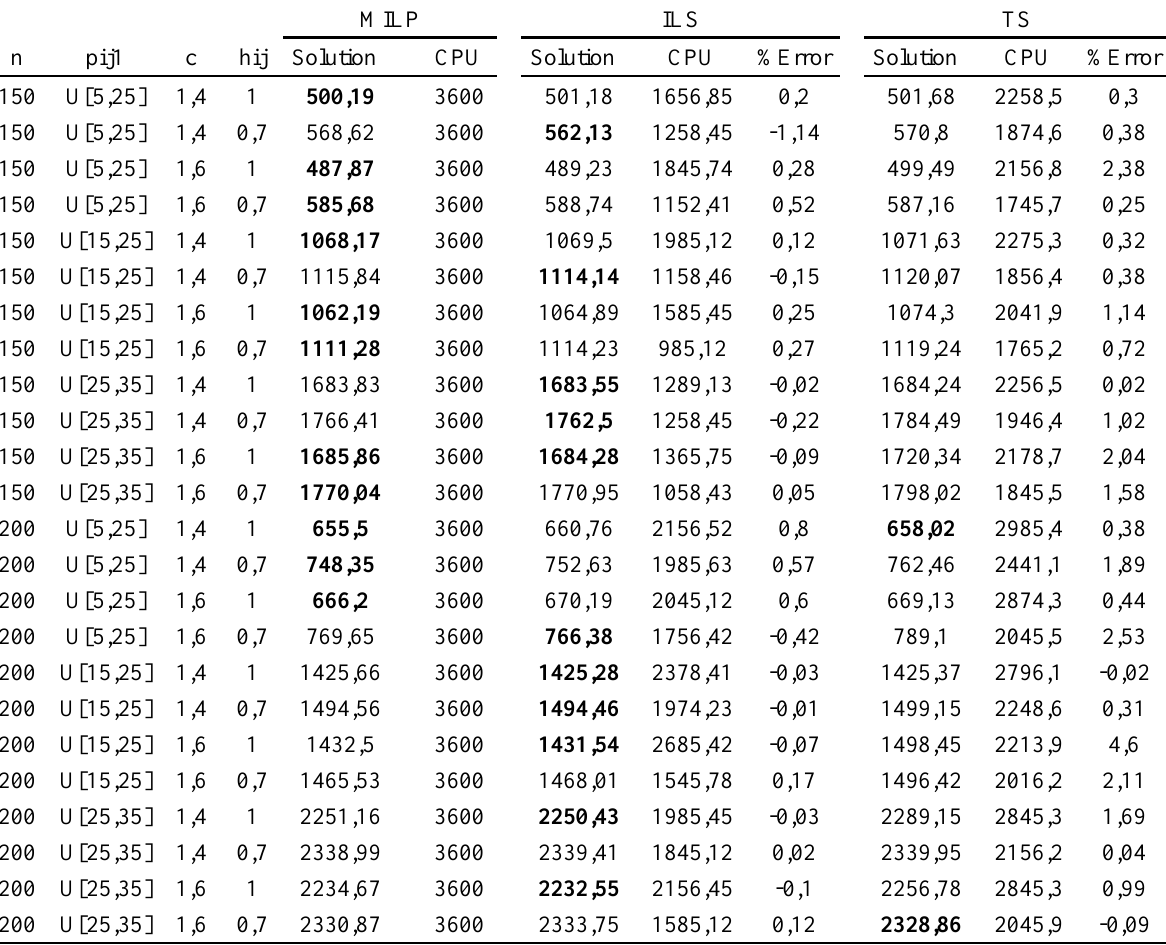
Table A2. Ten agent and 150 or 200